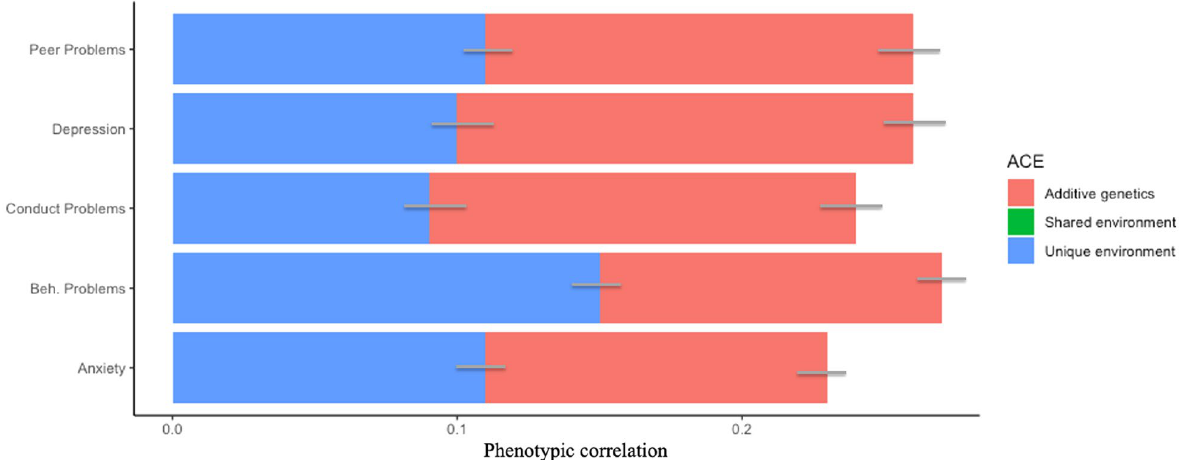
Figure 3. Genetic and environmental contribution to phenotypic associations between online victimisation and mental health. Note : Bars represent 95% confidence intervals around estimates. H Peer = total peer problems score derived from the subscale of the Strength and Difficulties Questionnaire (SDQ) 39 , Depression = depressive symptom scores measured by the Mood and Feelings Questionnaire (MFQ) 58 ; Conduct Problems = total conduct disorder symptoms derived from the subscale of the SDQ 39 . Beh. Problems = total behavioural problems score derived from the subscale of the SDQ 39 . Anxiety = total anxiety score derived from the subscale of the SDQ 39 .